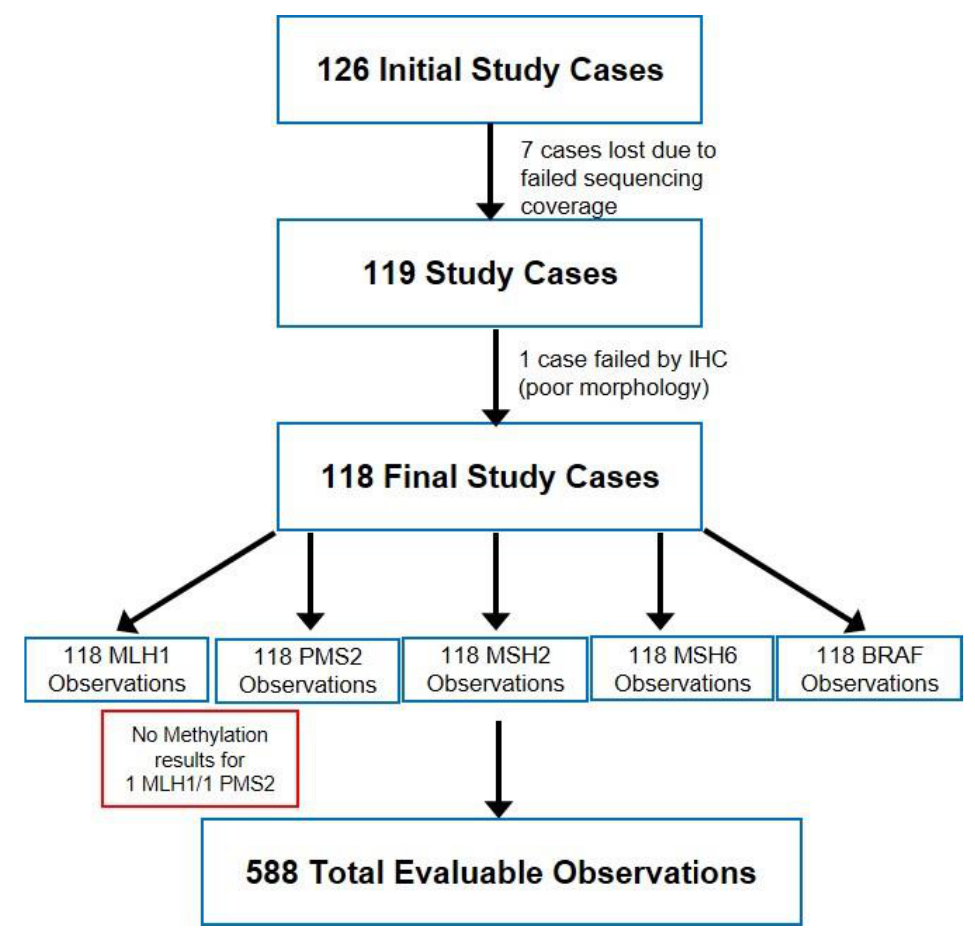
Figure 1. Study design and sample outcomes.